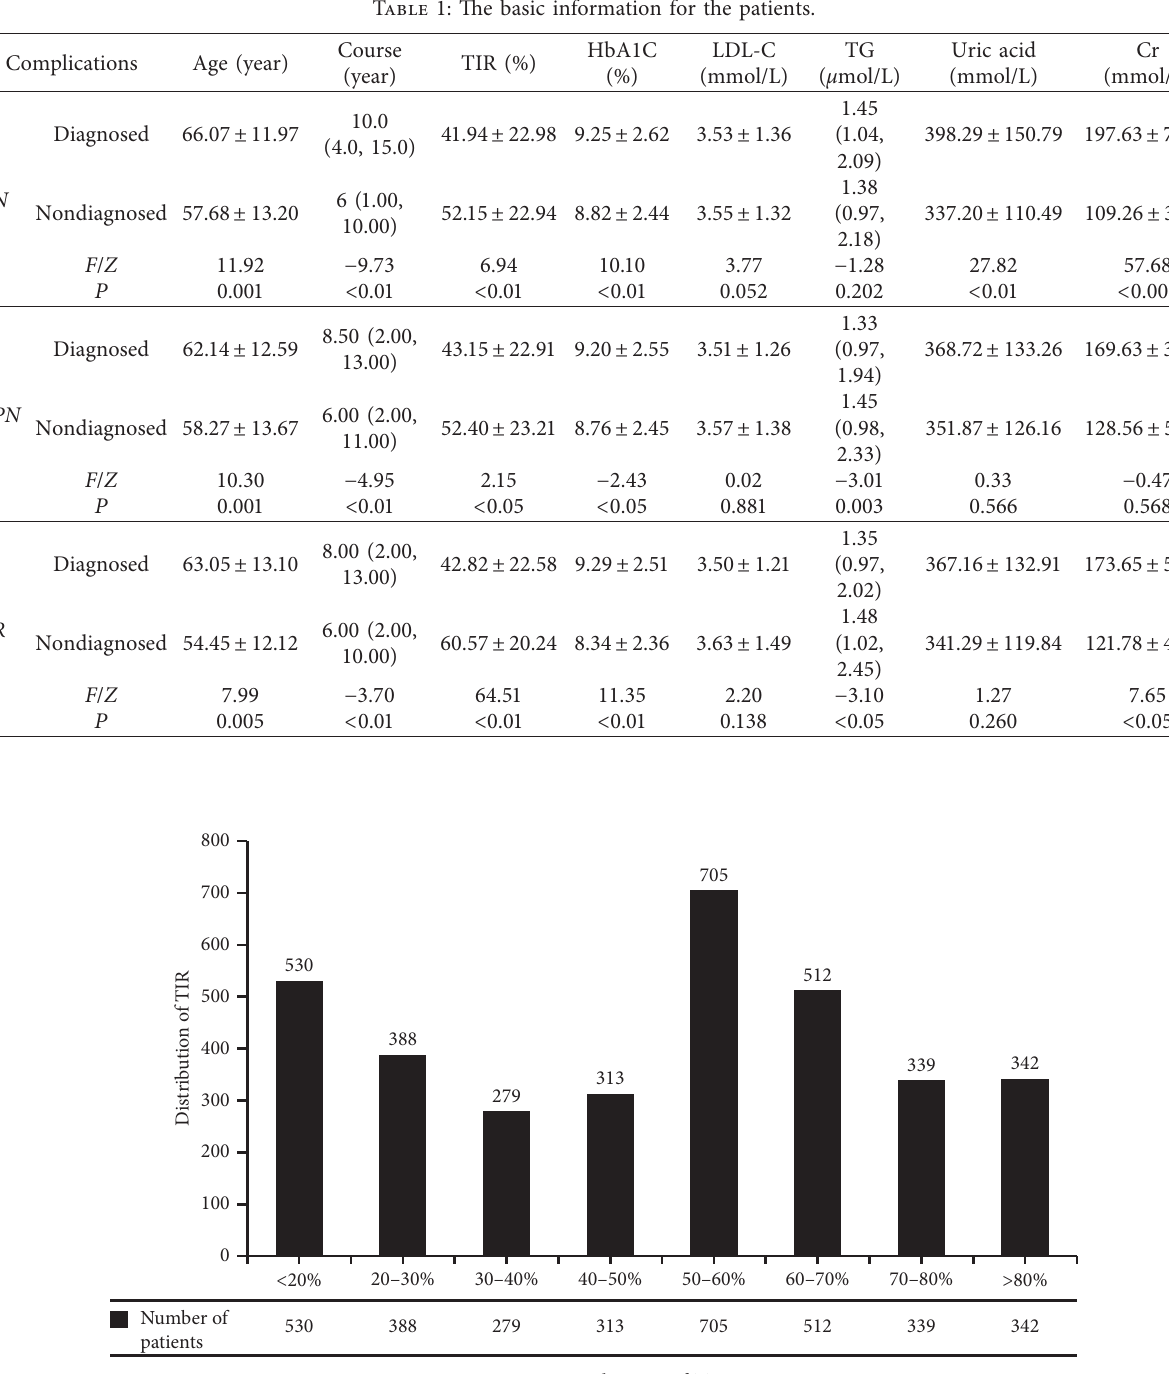
Figure 1: Distribution of TIR.